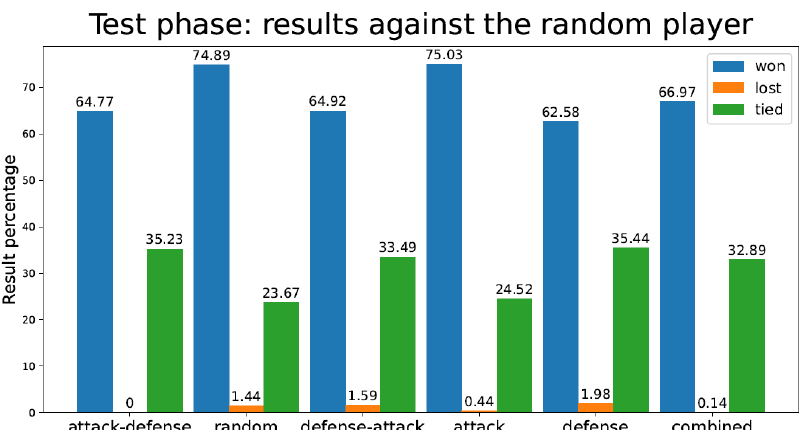
Figure 8. Percentage of test games won/lost/tied by the tic-tac-toe TD agent playing against a random player for the different training strategies.